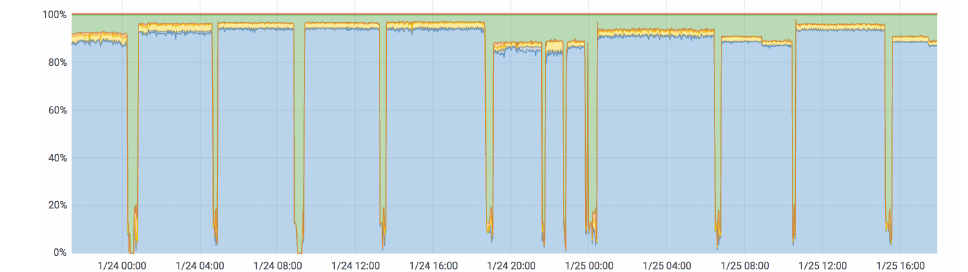
Figure 8: CPU utilisation of a typical worker node running with ARC in native mode.